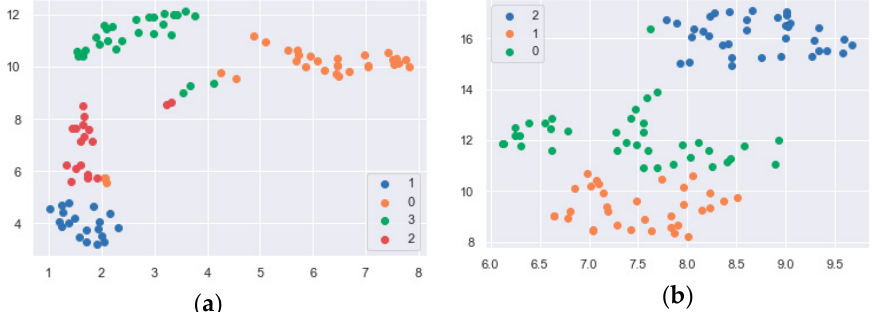
Figure 6. Tuna ( a ) and salmon ( b ) class clustering graph generated by the UMAP technique